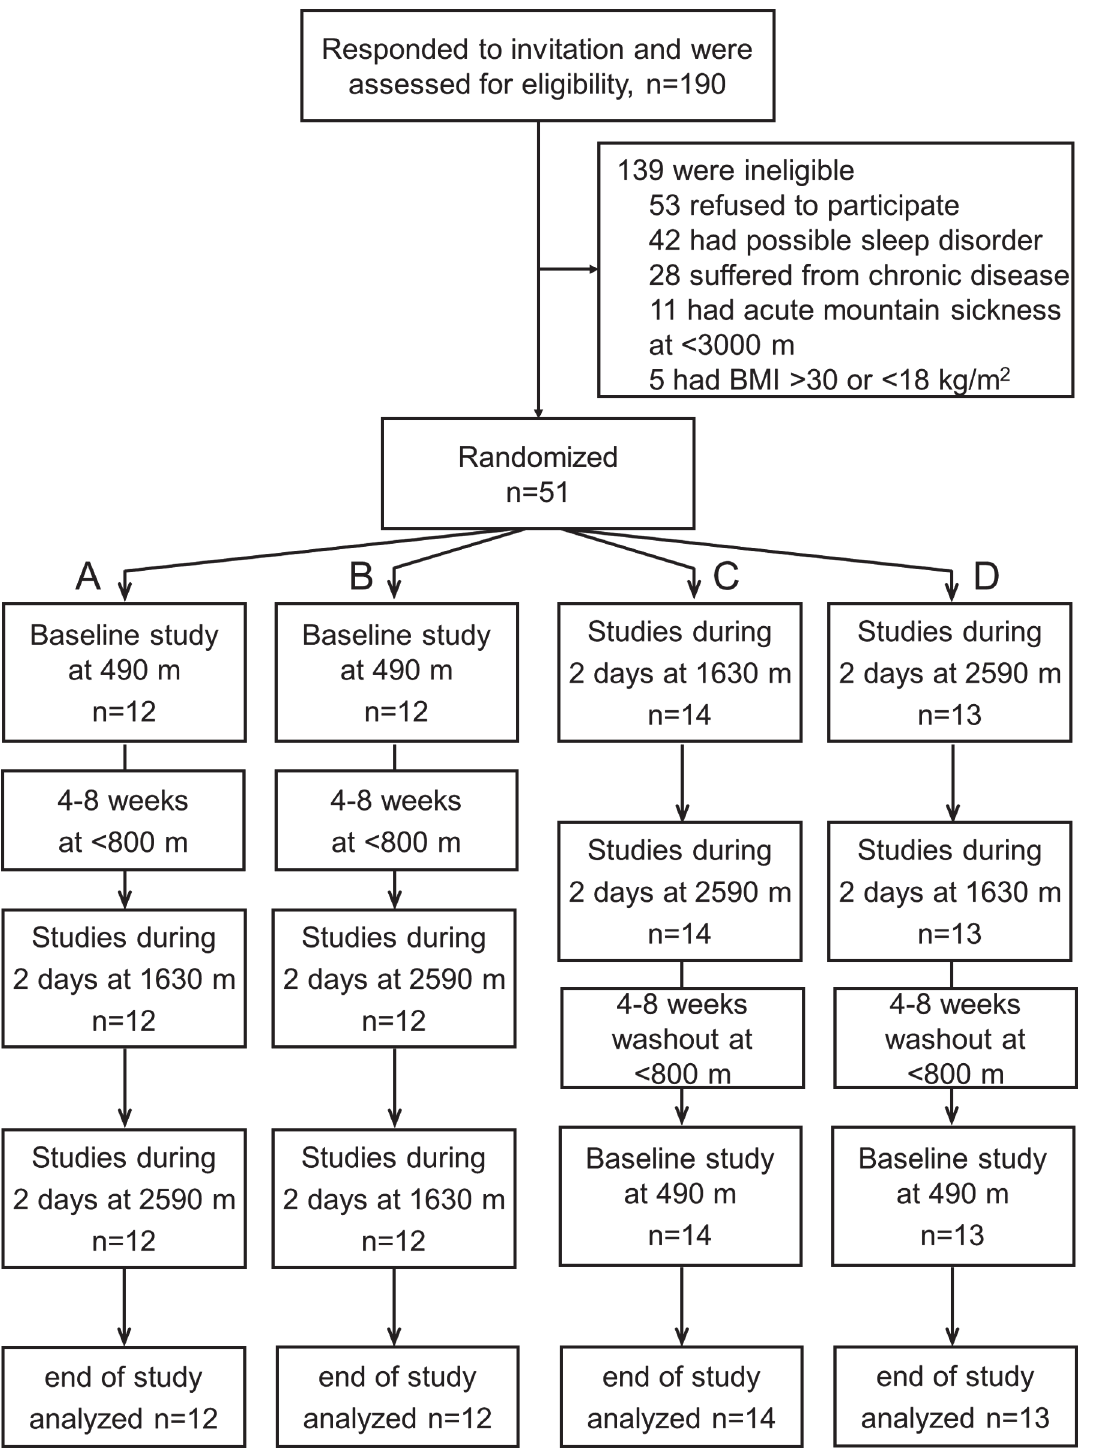
Fig 1. Consort flow chart. 51 participants were randomized to 4 differend schedules of altitude exposure. The flow chart is the same as that for the study reported in [12].